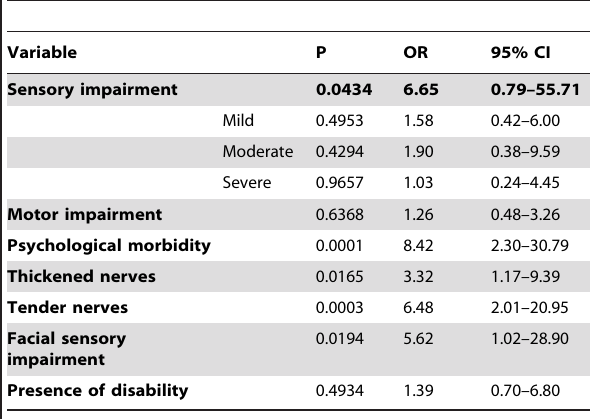
Table 3. Analysis of association of neuropathic pain with key leprosy clinical